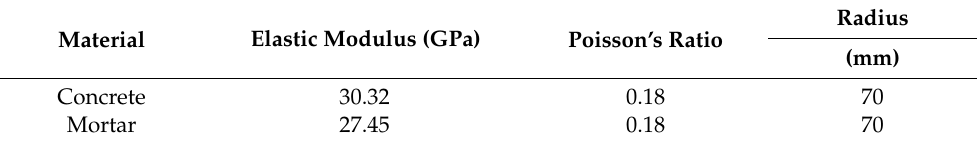
Table 3. Numerical input parameters.